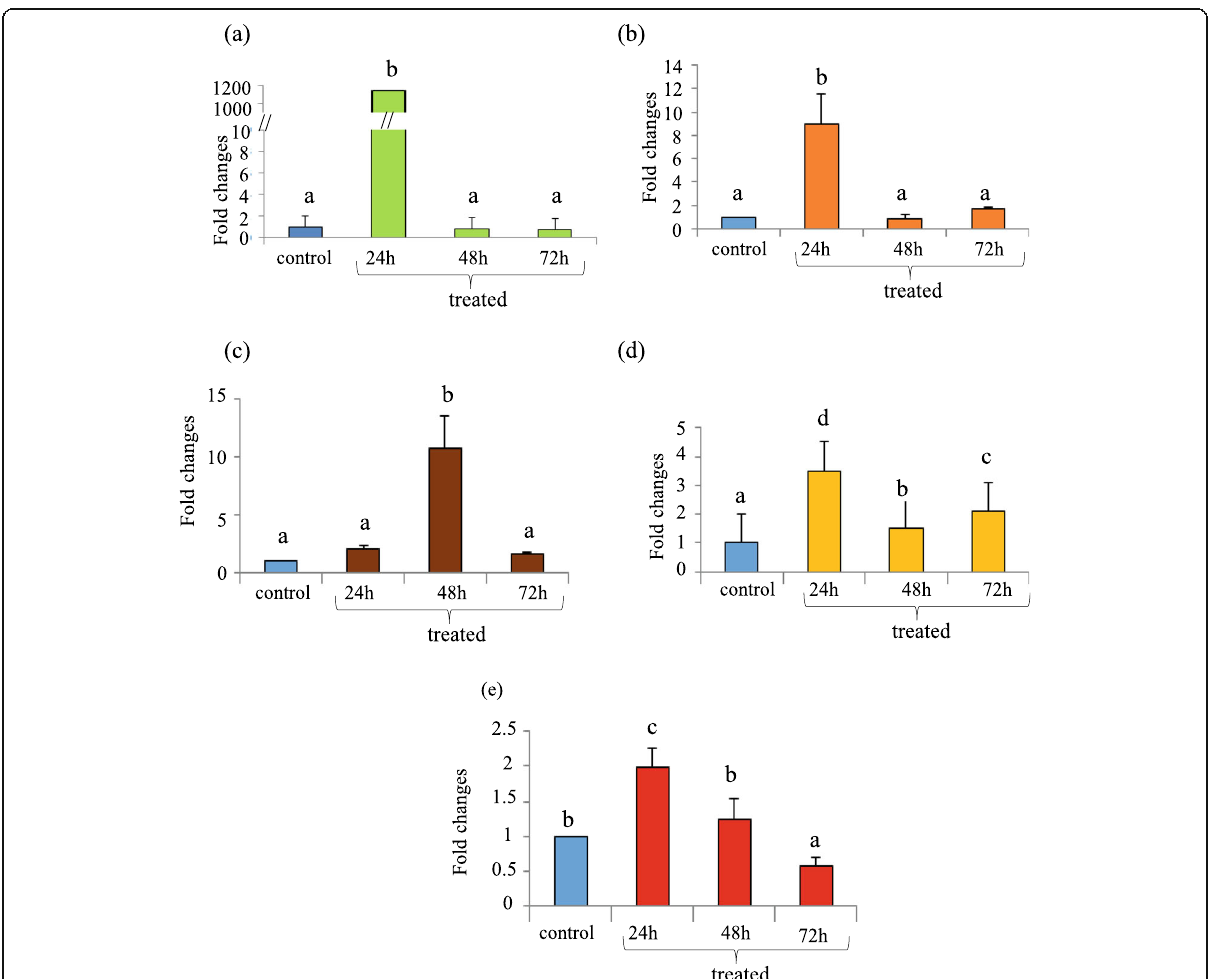
Fig. 6 Caspase-8 gene expression profile in Labeo rohita following A. hydrophila infection. Labeo rohita fingerlings ( n = 3) were injected with A. hydrophila (1 × 10 6 CFU/fish) by intra-peritoneal (i.p.) route. After 24, 48, and 72 h, total RNA was extracted from the gill, liver, kidney, spleen, and blood, and then, caspase-8 and β -actin gene expression in these tissues were analyzed by qRT-PCR. Expression of caspase-8 gene in each tissue was normalized to the β -actin gene, and relative expression of caspase-8 has been shown as fold changes compared to the un-treated control fish ( n = 3). a Gill. b Kidney. c Liver. d Spleen. e